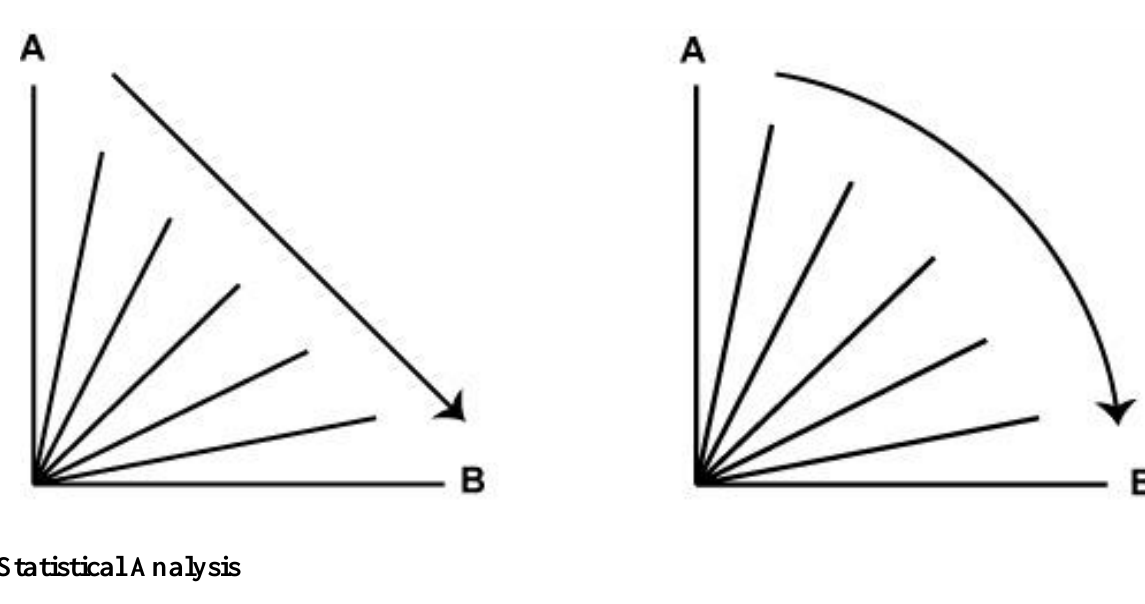
Figure 8. Conceptual representation of spherical linear interpolation (SLERP): instead of a naive linear interpolation ( left ) SLERP guarantees keeping constant velocity on the hyper-sphere surface ( right